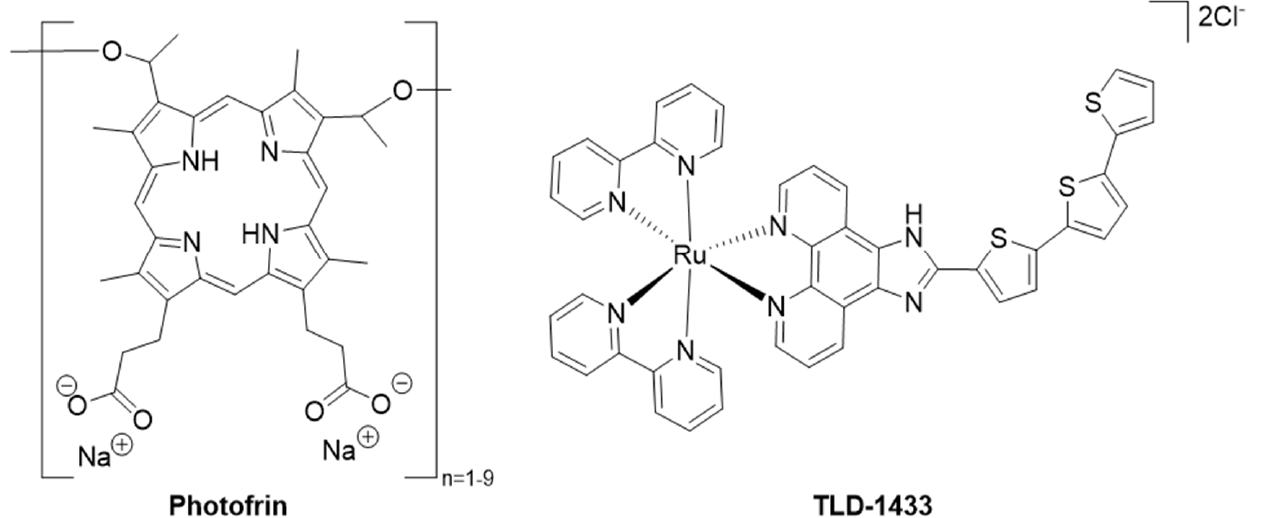
Figure 4. Structure of Photofrin (porfimer sodium) and the Ru(II)-complex TLD-1433 .